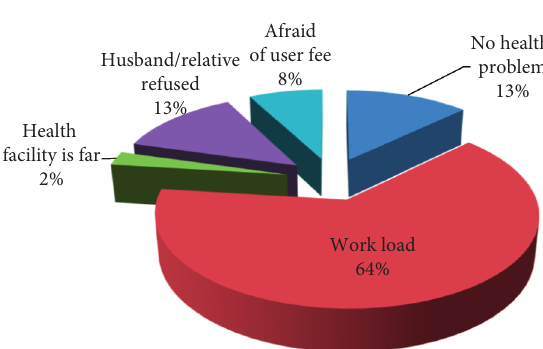
Figure 2: Reasons for not attending ANC